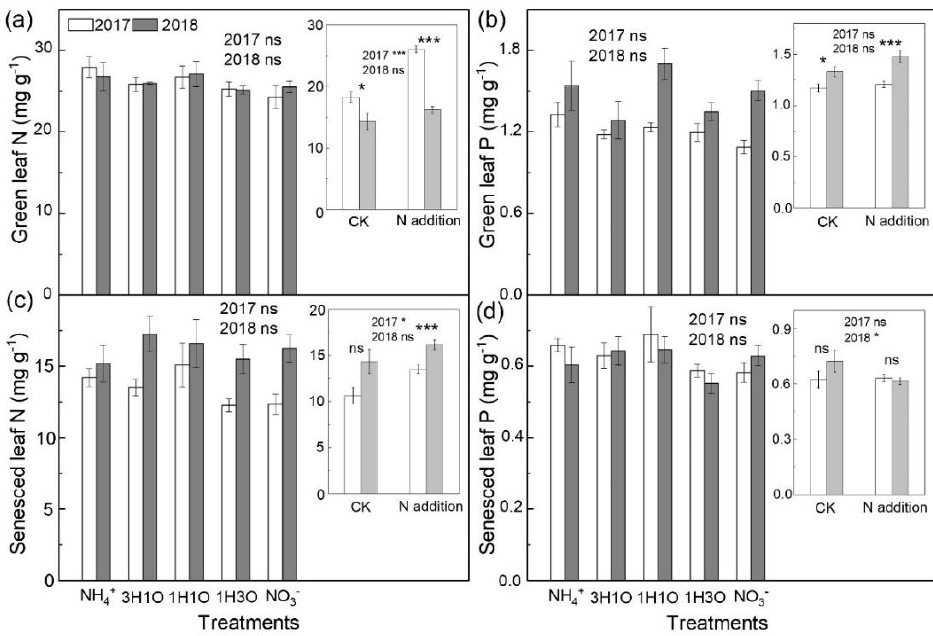
Figure 3. Response of leaf nutrient concentrations (including green leaf N ( a ) and P ( b ), senesced leaf N ( c ) and P ( d )) to various N fertilization forms. The asterisks and ns above the white and gray bar graphs represent the significance between 2017 and 2018. The asterisks and ns following the number of years inside the little figure represent the significance in control ( n = 4) and N addition (average, n = 20). The asterisks and ns following the number of years outside the figure represent the significance in N addition groups. * p < 0.05; ** p < 0.01; *** p < 0.001; ns, not significant. N fertilization significantly affected the green and senesced leaf N:P ratios (Figure 4). Although there was no significant difference in N:P ratio between 2017 and 2018, the N:P ratio of green leaf in 2017 was higher than that in 2018 under N application ( p < 0.01),